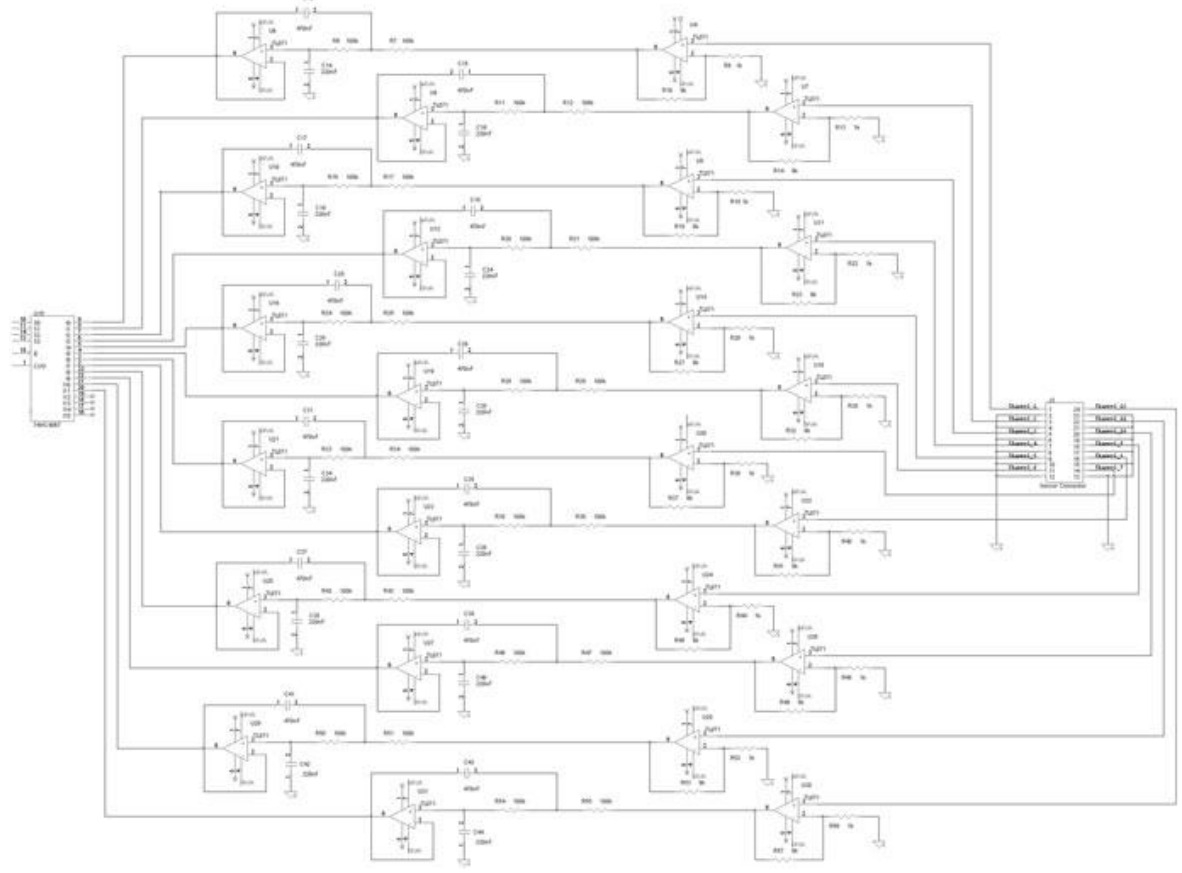
FIGURE 4. Diagram of the amplification and filtering circuit